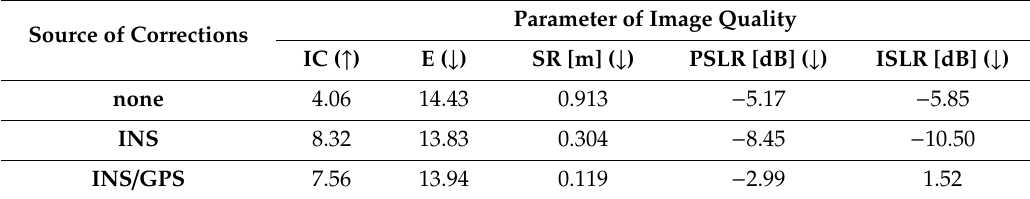
Table 3. Parameters of the quality of the selected SAR image.